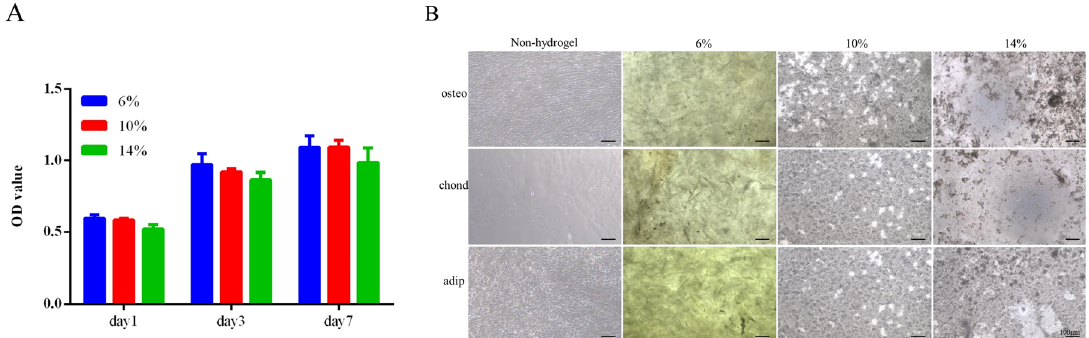
Fig. 3 Biocompatibility of hydrogels. A CCk-8 assay of hUMSCs culture in leach liquor of three hydrogels or medium as control for 1, 3 and 7 days. B Cellular morphology of hUMSCs culture on hydrogels or tissue culture plate in inducing media for 14